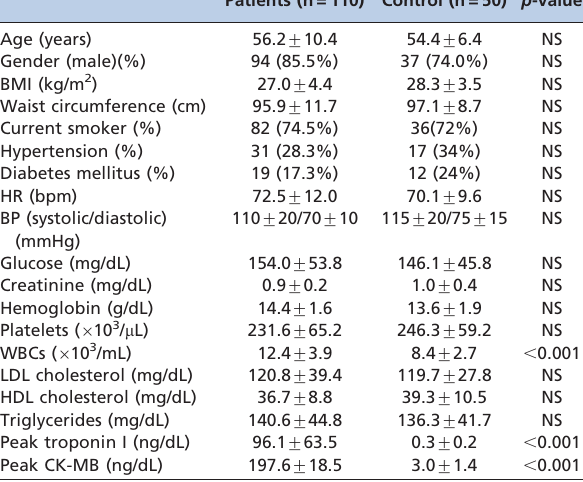
Table 1 - Demographic characteristics and